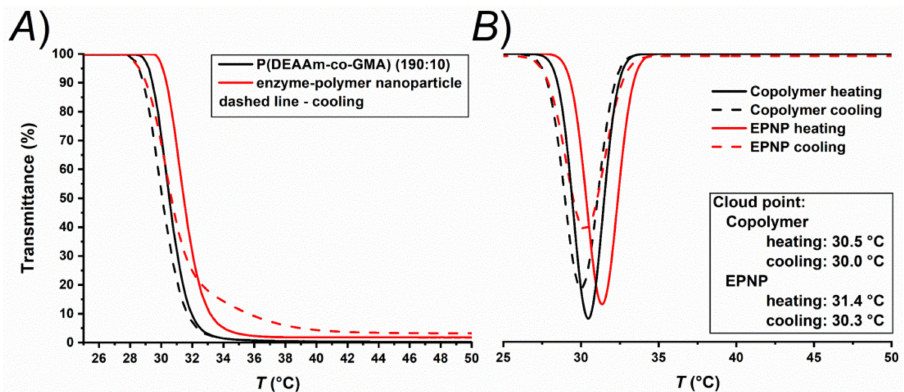
Figure 5. Transmittance vs. temperature curves ( A ) and its first derivatives ( B ) of the copolymer (black) and enzyme– polymer nanoparticle (red) in heating (full line) and cooling cycle (dashed line).